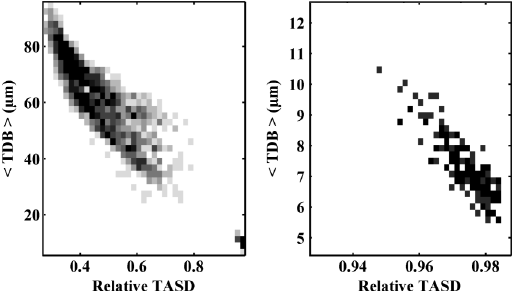
FIG. 12. Relative TASD as a function of h TDB i at the plane z ¼ 0 μ m. Left: ξ 400 ð 3 . 8 μ rad ; 0 ; 0 Þ (small area in the bottom right corner) mixed with ξ 3200 ð 3 . 8 μ rad ; 20 μ rad ; 20 μ m Þ (large area in the upper left part of the plot). Right: ξ 3 . 8 μ rad ; 0 ; 0 Þ , i.e., zoom on the small area in the bottom 400 ð right corner of the left